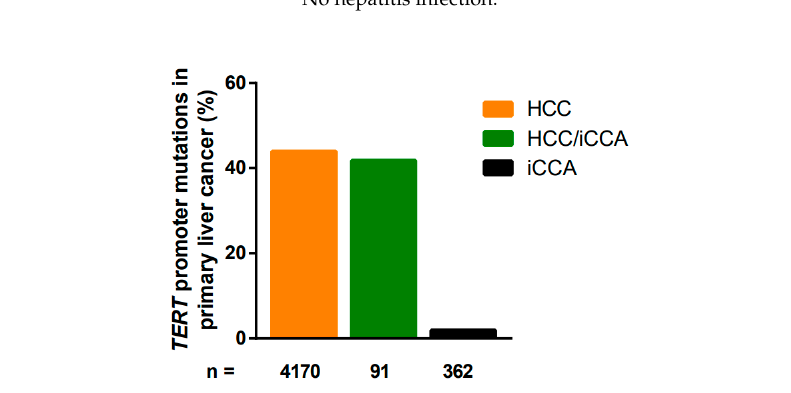
Figure 2. Distribution of TERT promoter mutations in liver carcinoma.